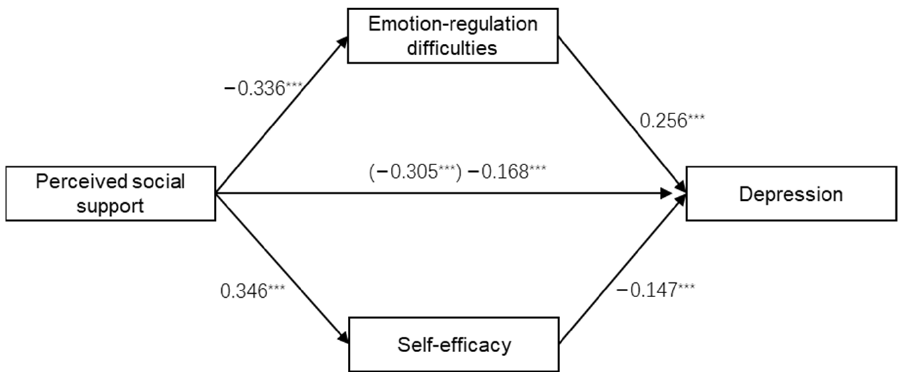
Figure 1. The mediating model for perceived social support, emotion-regulation difficulties, self- efficacy, and depression (N = 511, *** p < 0.001).